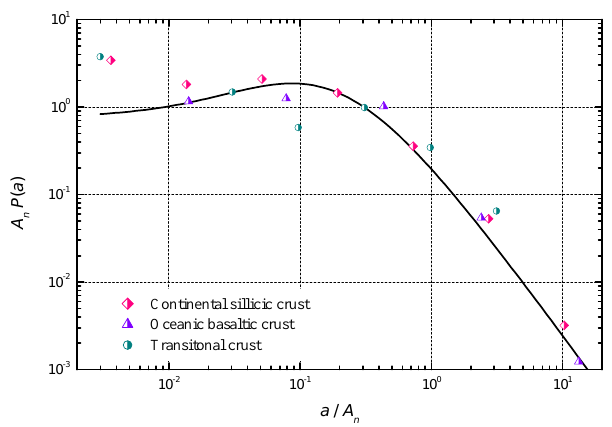
each crustal type (Table 1). The solid curve is a fit to the rescaled distributions and is given by the GEV distribution, Eq. (2), with θ = 0 . 94 ± 0 . 16, µ = 0 . 22 ± 0 . 04, and σ = 0 . 28 ± 0 .